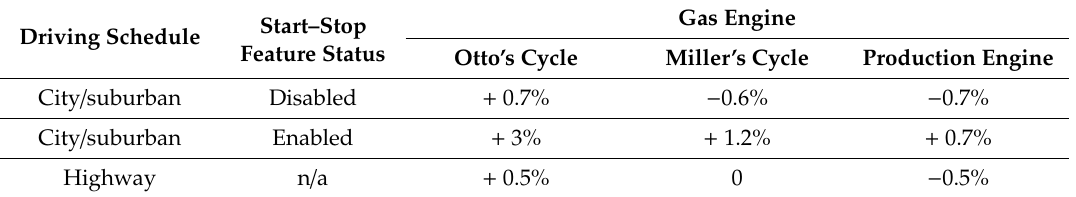
Table9. Averagehybridizationeffectofthegas-basedpowertrainsrelativetothediesel-basedpowertrain.